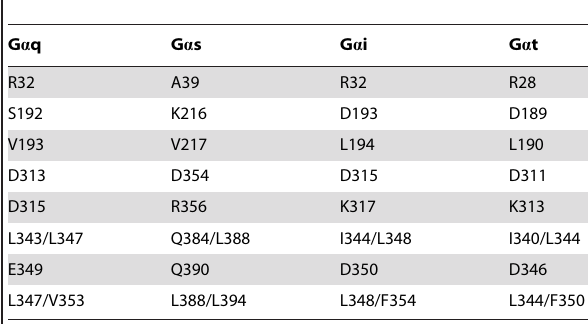
Table 4. Comparison between G a q, G a s, G a i and G a